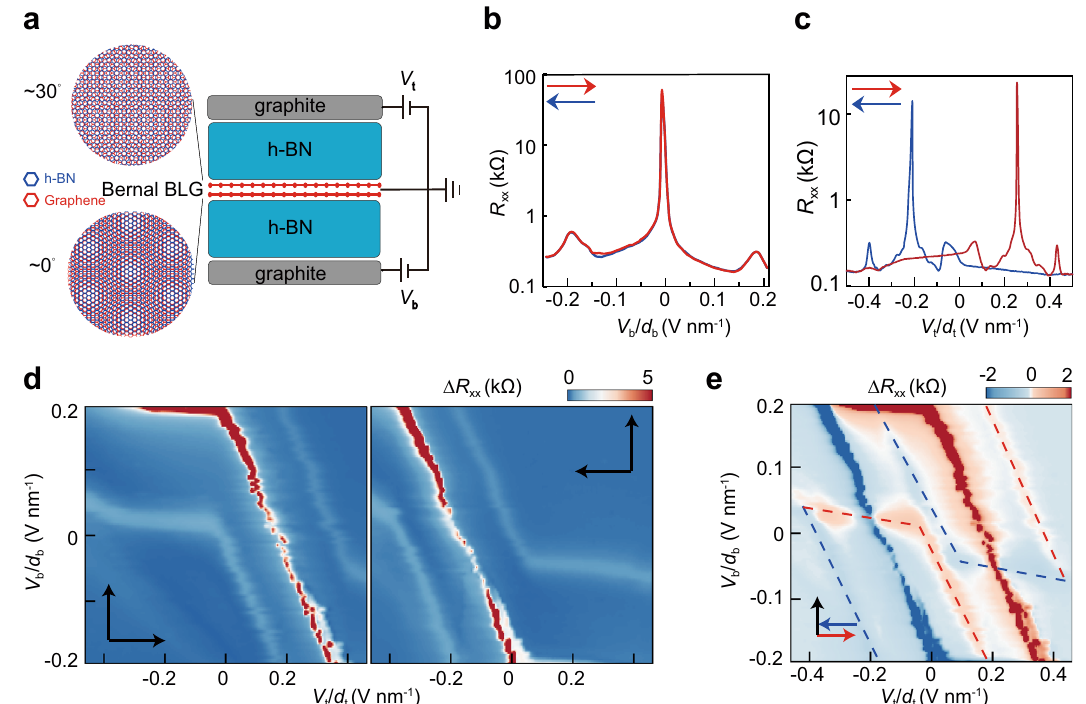
d Acompletephasediagramofresistanceisconstructedbysweeping V t forth(left) andback(right)whileincreasing V b inastep-by-stepfashion.Anomalousscreening atbothCNPand FFPcouldbeidenti fi ed byhorizontallines(red andwhiteincolor, respectively). e Difference in resistance between the two panels in d . Multiple hysteresis loops are formed by three pairs of blue and red peak lines at CNP and FFP.NotethattheloopsforelectronandholeFFP(highlightedbydashedlines)are only half of a closed